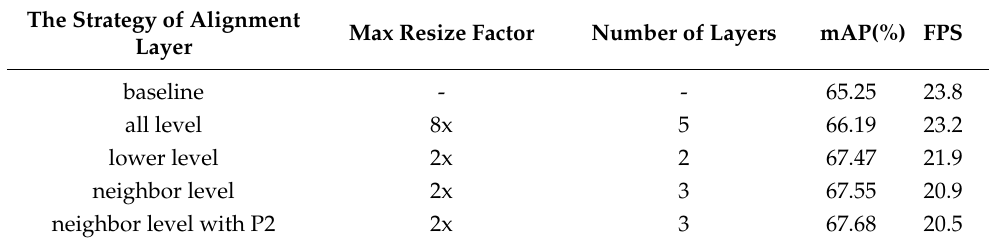
Table 2. Multi-scale hierarchical selection strategy within different pyramid features.